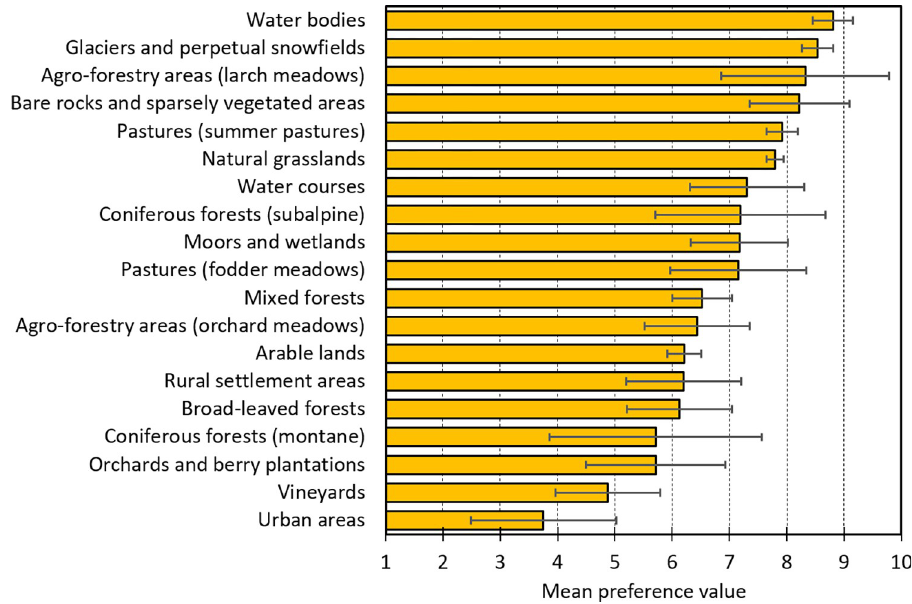
Fig 4. Mean preference values ( � x � � s : d : , n = 4–5) of different LULC types, ranging from 1 = ‘least preferred’ to 10 = ‘most preferred’ (Likert